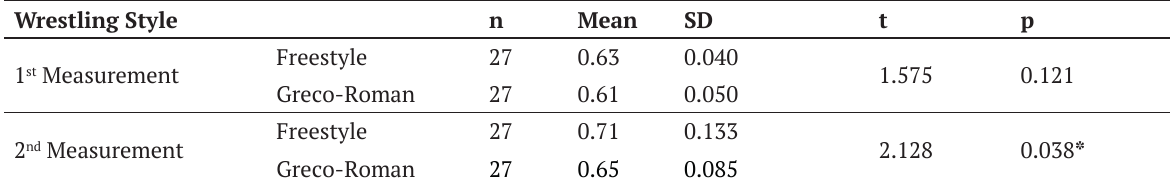
Table 2. Footprint analysis results of the control group by the wrestling style